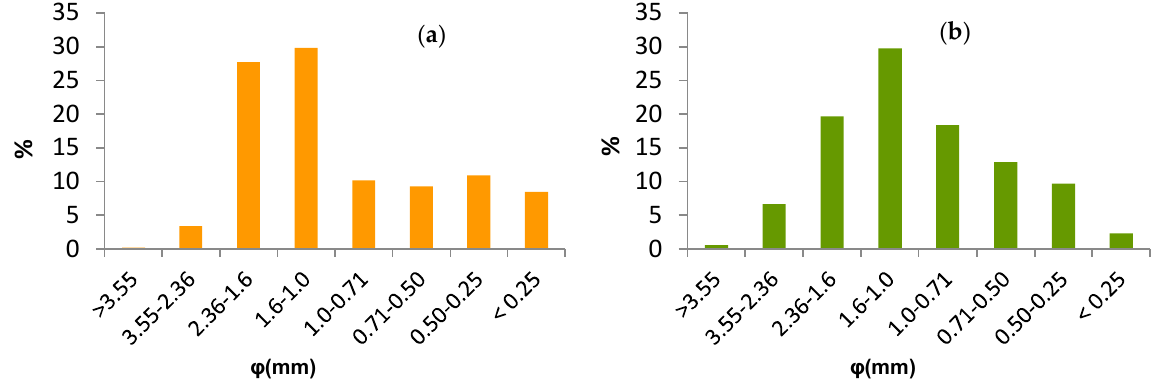
Figure 1. Particle size distribution (expressed in g/100 g of raw material) of the wheat straw ( a ) and eucalyptus residue ( b ) samples used in this work.